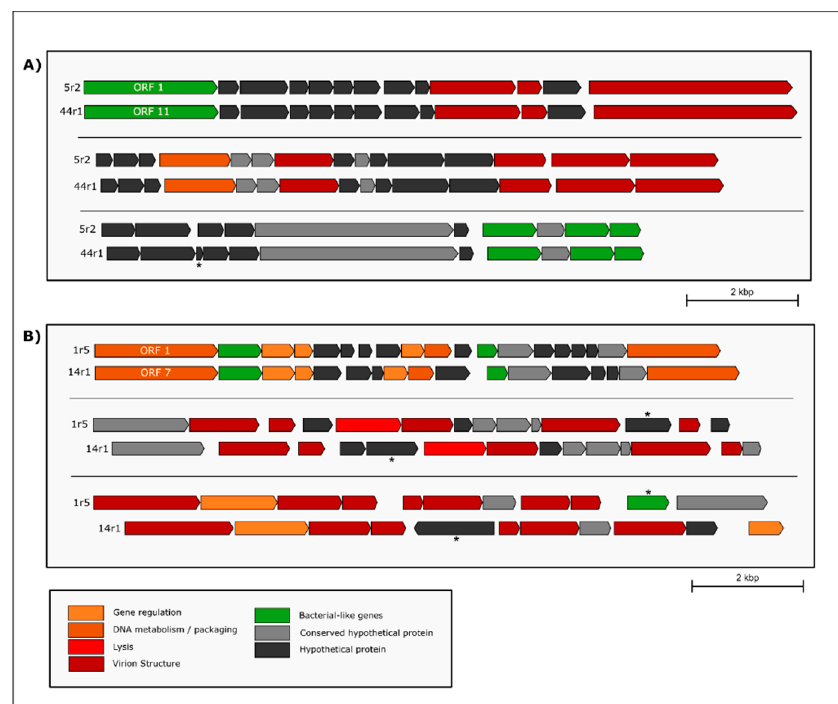
Figure 6. Comparative map of SRP prophages with a high level of synteny. ( A ) Fragment of high synteny between the prophages 5r2 ( Desulfovibrio aespoeensis Aspo-2) and 44r1 ( Desulfovibrio alaskensis G20), which contain a high prevalence of hypothetical proteins. ( B ) Fragment of high synteny between prophages 1r5 ( Desulfovibrio vulgaris str. Hildenborough) and 14r1 ( Desulfovibrio vulgaris str. Miyazaki). The asterisks indicate those ORFs not shared by both prophages. Annotation was made by Diamond and DNA Master.